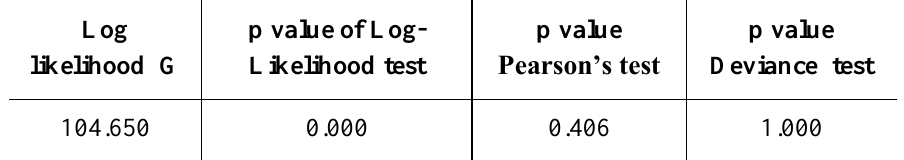
Table 04: Results of Ordinal Logistic Regression Predictor Coef SE Coef z P Lower Upper Const(1)